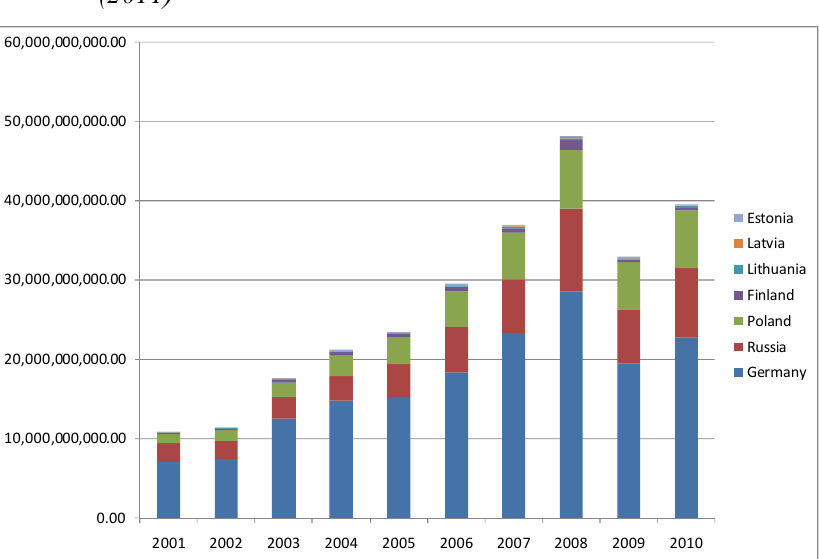
Figure 4 Slovakian trade (import and export) with Rail Baltica Growth Corridor countries during period of 2001-2010. Source: United Nations